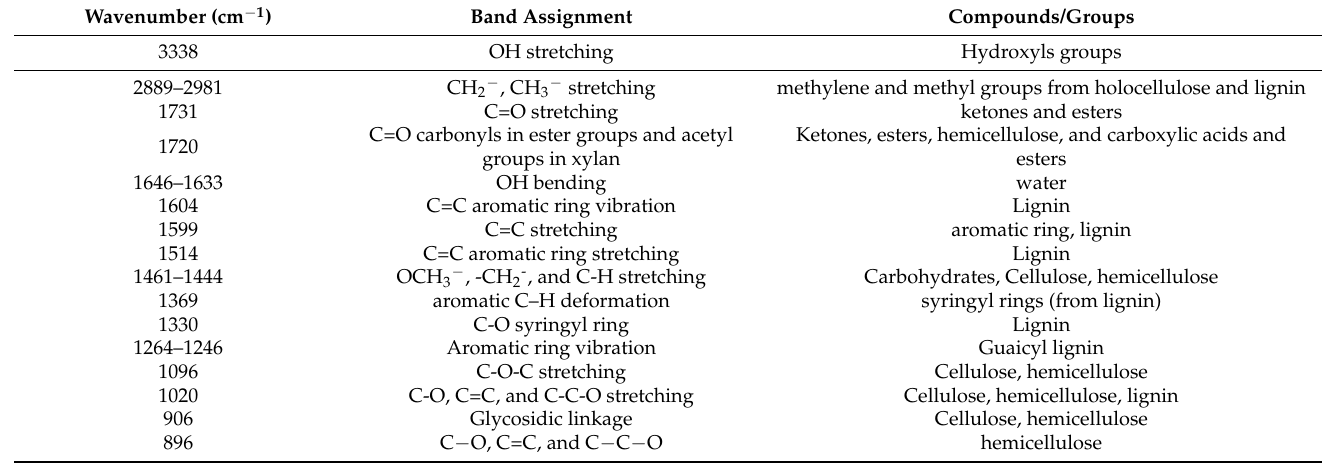
Table 3. FTIR band assignments [36–40].